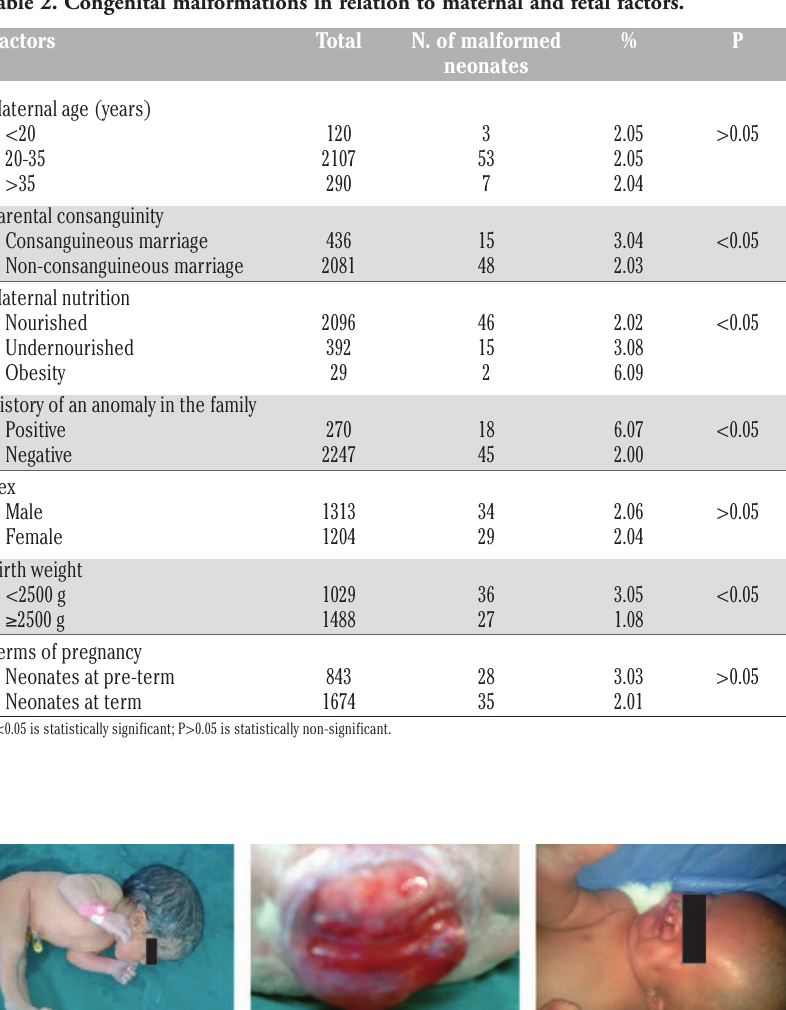
Table 2. Congenital malformations in relation to maternal and fetal factors.